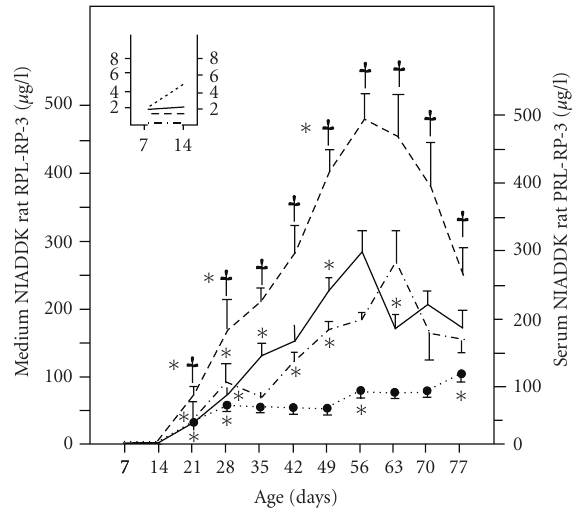
Figure 2: Age-related changes in serum concentrations of prolactin (dotted line), release of prolactin by whole pituitary (free release; dashed line), hypothalamic prolactin-releasing activity (solid line), and hypothalamic prolactin-inhibiting activity (dotted-dashed line) in male rats. Values are mean ± SEM from two separate experiments and a minimum number of 14 animals per pooled group. ∗ P < . 05 compared with preceding group; † P < . 05 compared with hypothalamic prolactin-releasing activity at the same age (Student’s t -test). The inset shows the results for days 7 and 14 on an expanded scale. The pituitary constructs were dissected out of 7 to 77 day-old rats and incubated in DMEM for 4 hours at 37 ◦ C. Prolactin was estimated by RIA in the spent medium